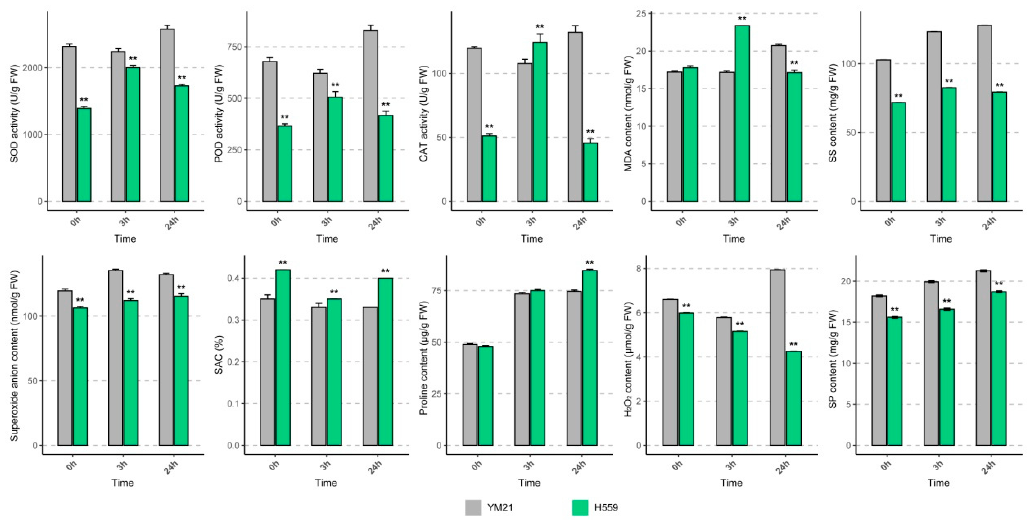
Figure 2. Physiological changes in young cotyledons of H559 and YM21 under chilling stress (4 °C) at di ff erent time points. These physiological indices include superoxide dismutase (SOD) activity, peroxidase (POD) activity, catalase (CAT) activity, malondialdehyde (MDA) content, soluble sugar (SS) content, soluble protein (SP) content, O 2 − content, H 2 O 2 content, proline content, and superoxide anion scavenging (SAC) rate. Error bar indicates the standard error (SE) of the mean ( n = 3). The asterisk indicates a significant di ff erence level between H559 and YM21 (** p < 0.01).